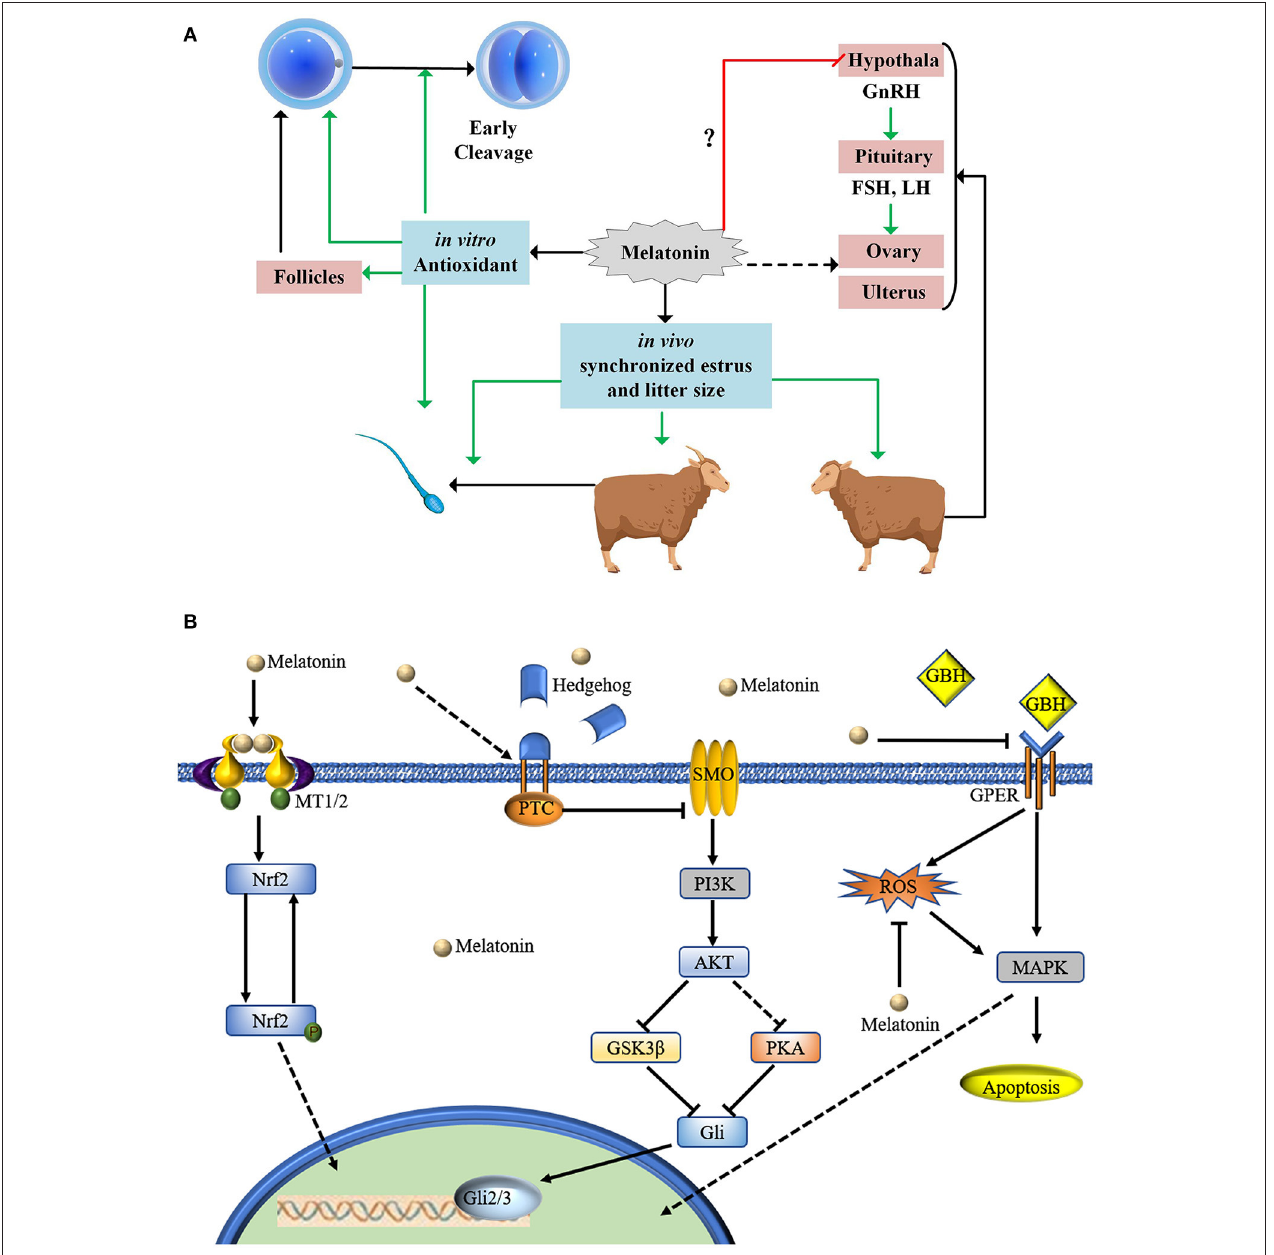
FIGURE 4 | Proposed mode of action of MT in relation to sheep oocyte developmental competence. (A) MT treatment of sheep oocytes cultured in vitro has antioxidant effects and can increase oocyte development potential. MT can improve early cleavage. Implantation of MT in ewes and rams can promote estrus. There is no evidence to indicate whether implanting MT in ewes inhibits the hypothalamus-gonadal axis. Implanted MT can be enriched in follicles through the blood ovum barrier. Our statistical results show that implanting MT can increase the number of fetuses. (B) MT is involved in many oocyte-related signaling